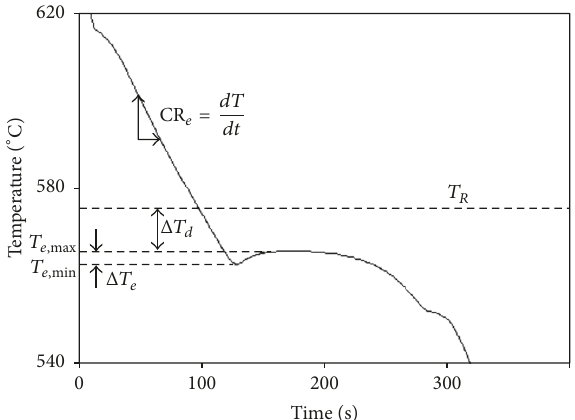
Figure 2: Solidification parameters of 356 alloy